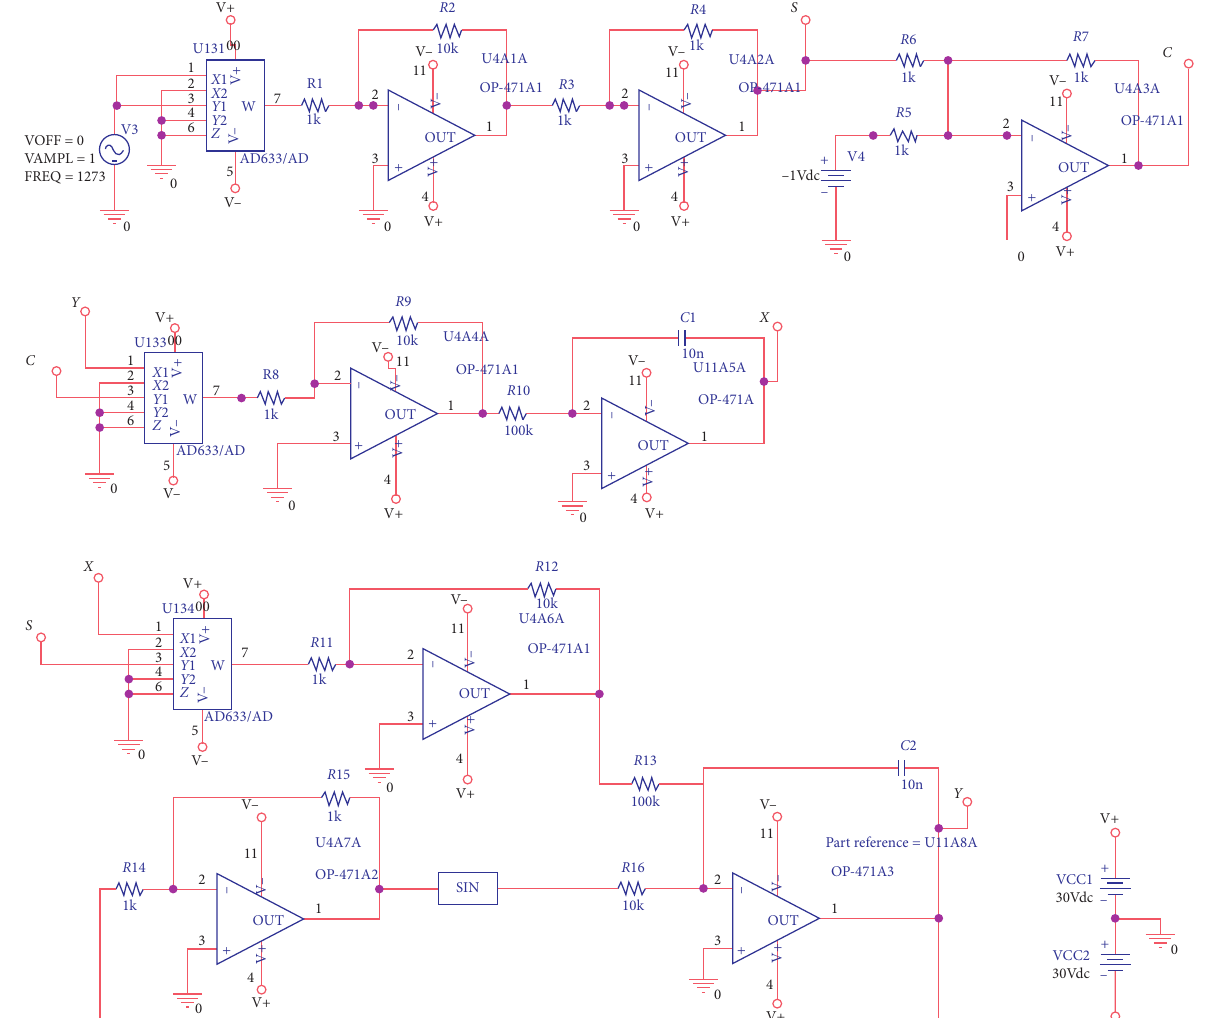
Figure 8: The circuit schematic of the introduced system (Pspice (version 9.1)). The elements values are chosen to represent the system when its parameters are considered w � 0 . 8 and A � 1. The system time is scaled T � t / α when α � ( R � 10 K Ω ) × ( C � 10nF ) � 10000.